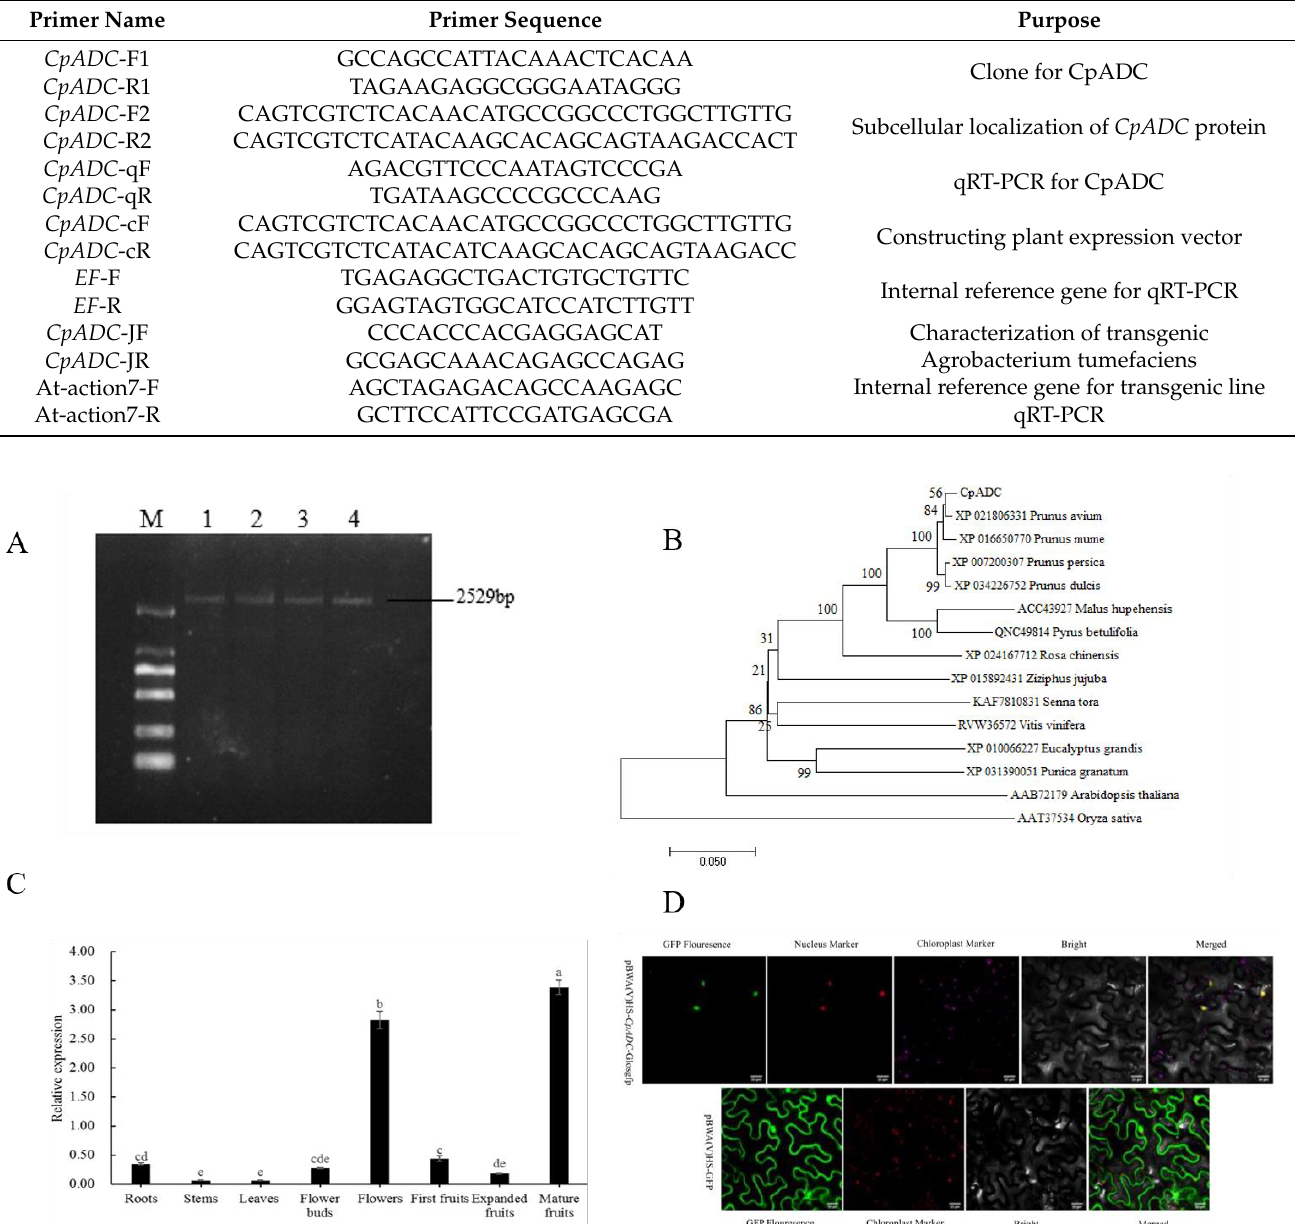
Table 1. The sequences of primers used for CpAD C cloning, its expression quantification and so on.